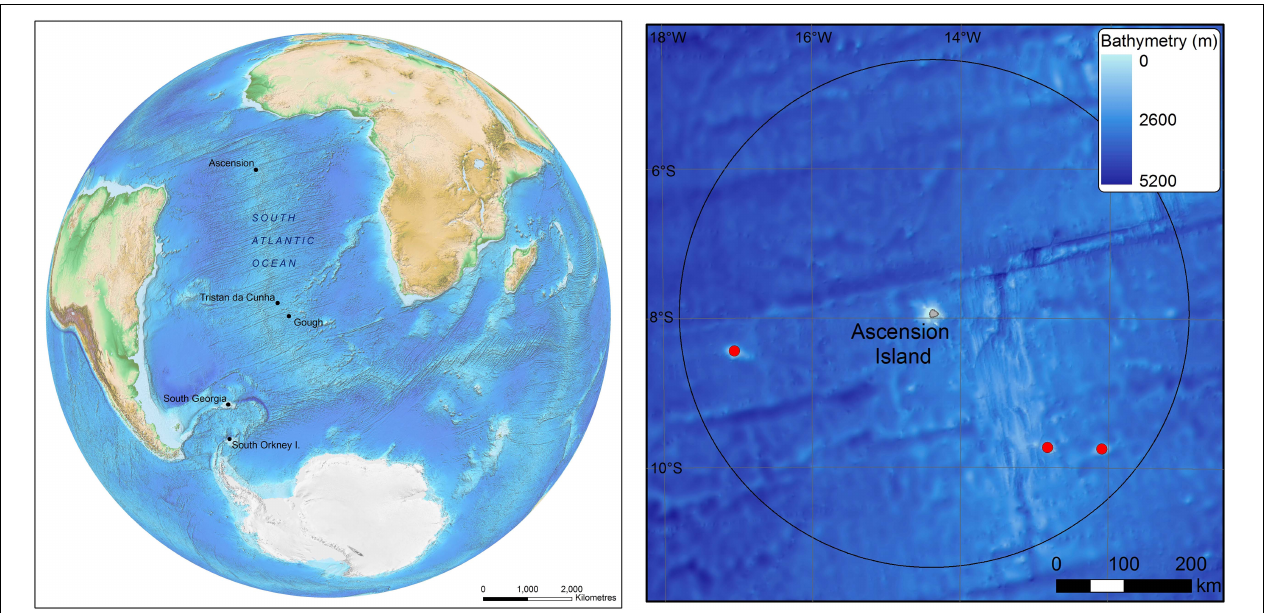
FIGURE 1 | The position of Ascension Island in the South Atlantic (left) and the island and seamounts (red dots) within it’s Exclusive Economic Zone. Bathymetric data is GEBCO held by the British Oceanographic Data Centre (The GEBCO_2014 Grid, version 20150318,